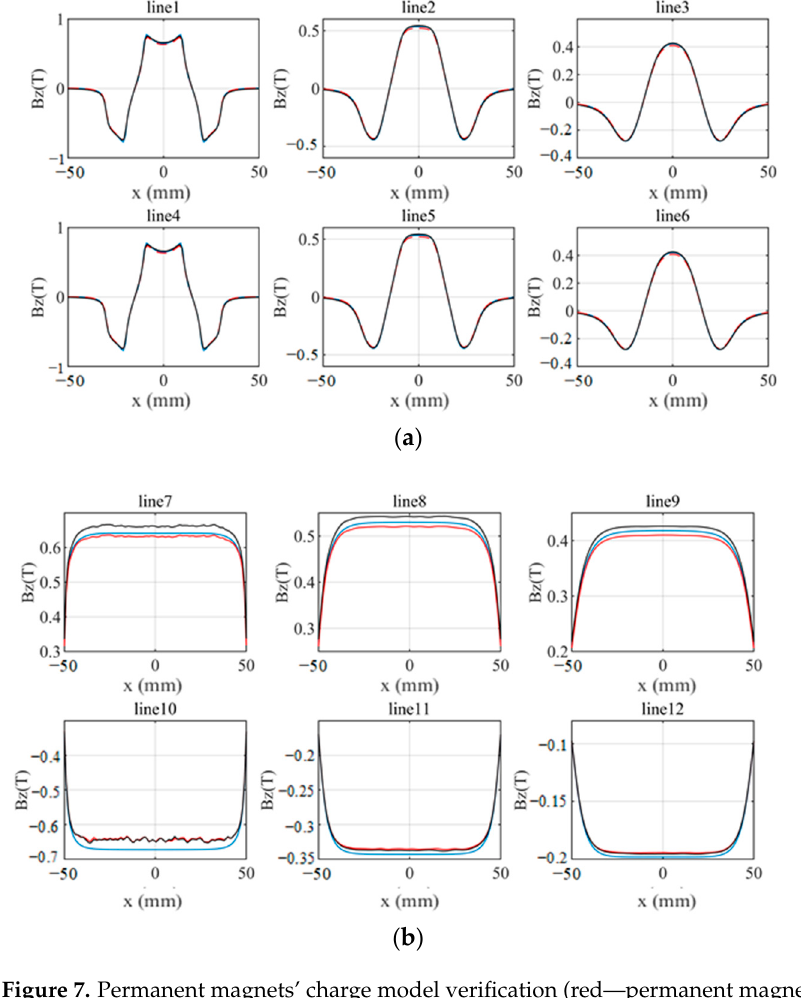
Figure 7. Permanent magnets’ charge model verification (red—permanent magnet array, 3D simu- lation; blue—analytical solution; black—magnet array with 3D yoke simulation). ( a ) x-direction and ( b ) y-direction.